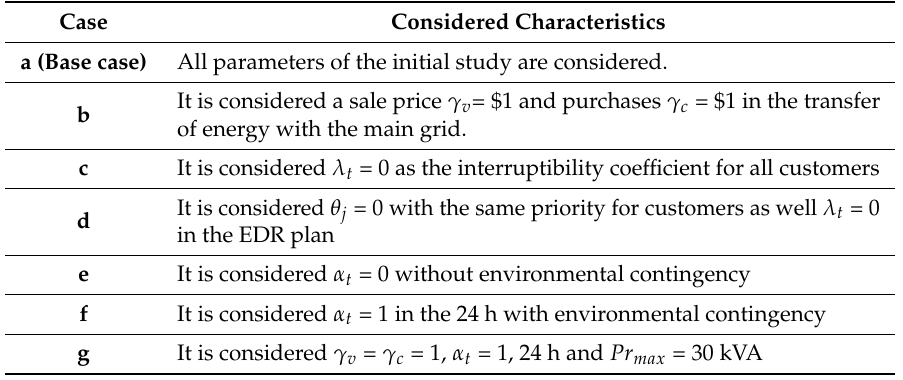
Table 6. Parameters considered in the cases.